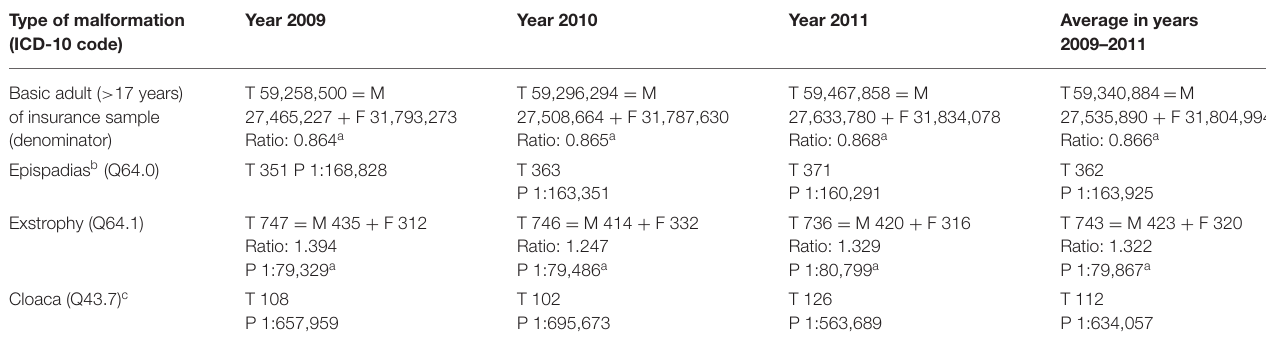
TABLE 2 | Outpatient data of adult (18 years onwards) EEC patients. Type of malformation (ICD-10